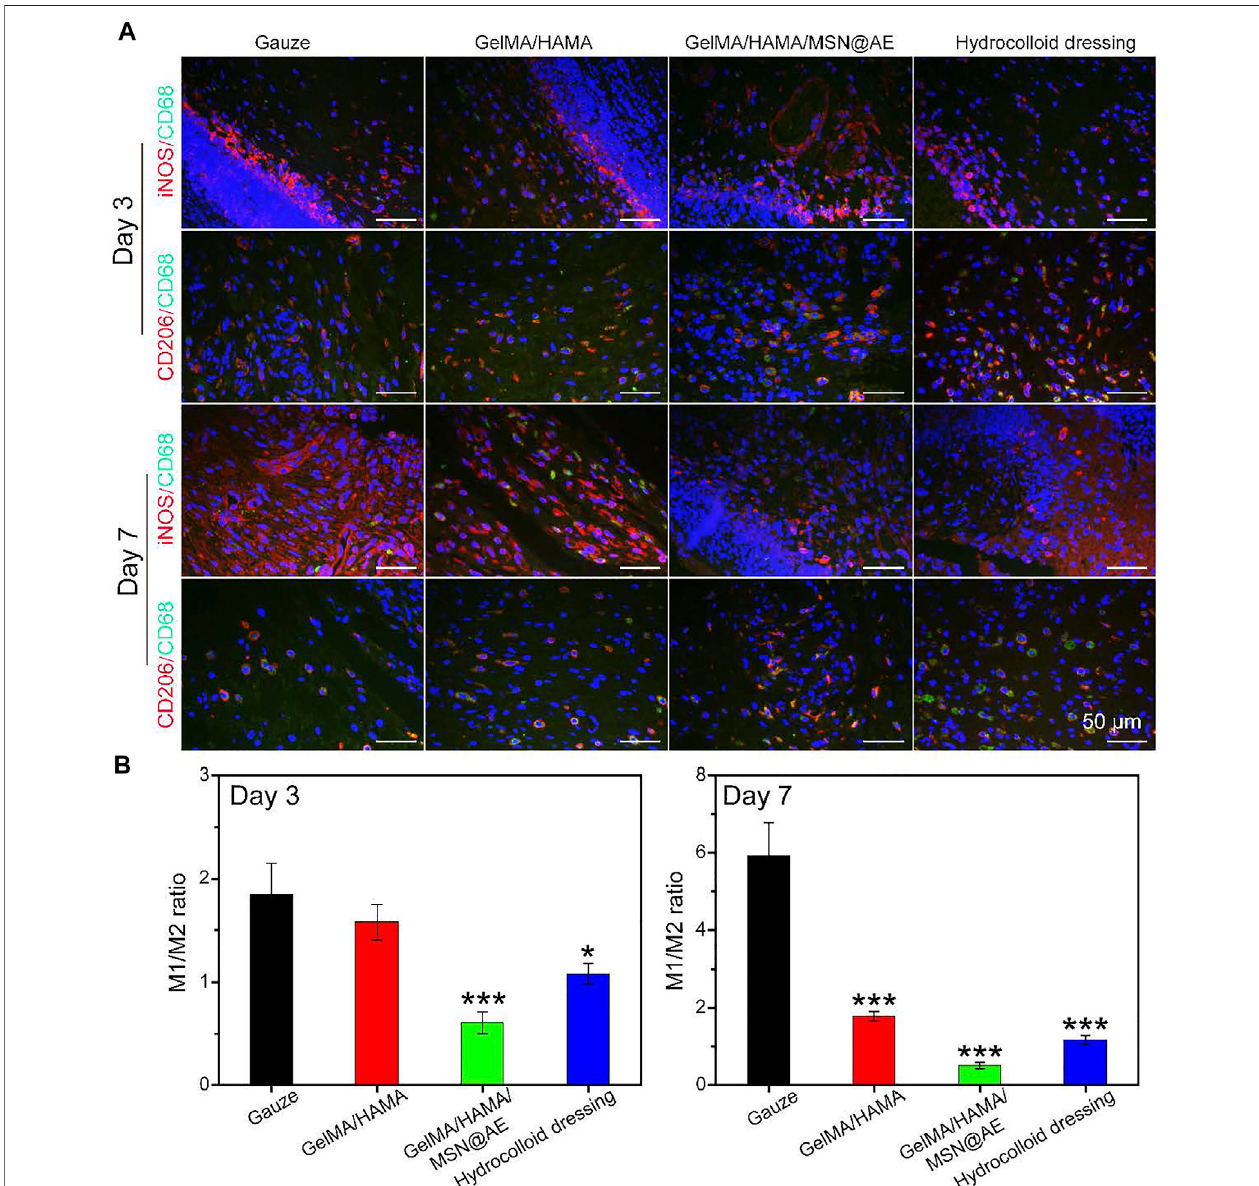
FIGURE 9 | (A) Representative iNOS (red), CD206 (red) and CD68 (green) images of immuno fl uorescence staining of wound sections treated with each group at day 3 and day 7. (B) Ratio of M1 to M2 analysis of each group (* p < 0.05, ** p < 0.01, and *** p <